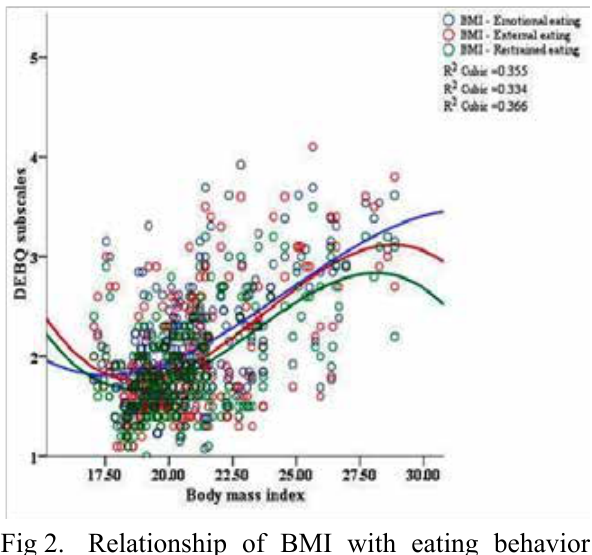
Fig 2. Relationship of BMI with eating behavior subscales of DEBQ Stress and BMI in adolescents